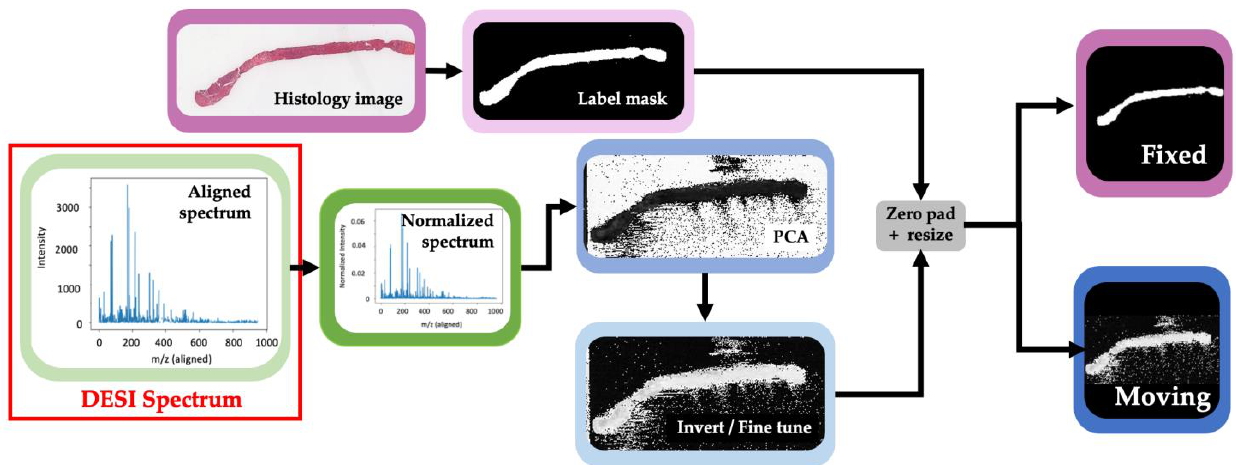
Figure 3. Full preprocessing pipeline. Top row demonstrates the steps for processing the histology images. Bottom row demonstrates the process for representing DESI scans as a 2D image. Output on the right is the final two images used for registration. Histology images are considered as fixed while DESI data is considered as moving.